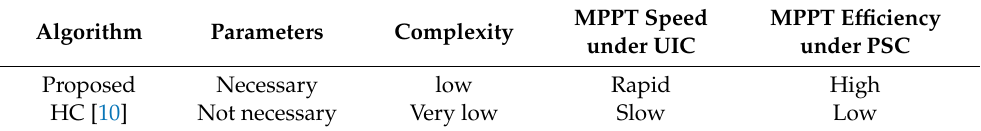
Table 7. Properties comparison of two